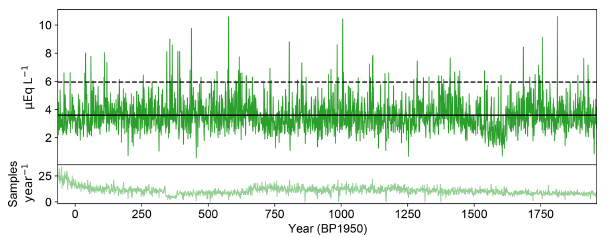
Figure 9. Time series for annually averaged sodium. Solid black line indicates the 2000-year mean value. Dashed black line indi- cates 2 σ value. The lower panel indicates the number of individual samples in the year used for the average value.